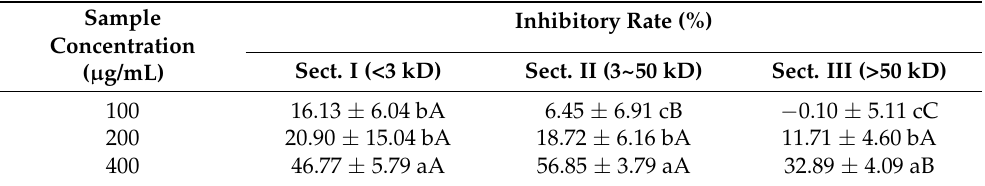
Table 1. Inhibitory rates of cell proliferation (SGC-7901 cells) induced by various components of A. chinensis hemolymph separated by ultrafiltration after 48 h